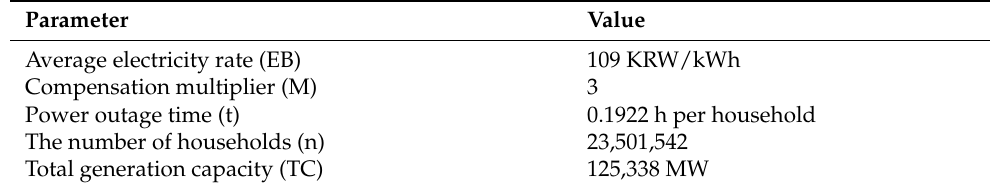
Table 4. Parameters for